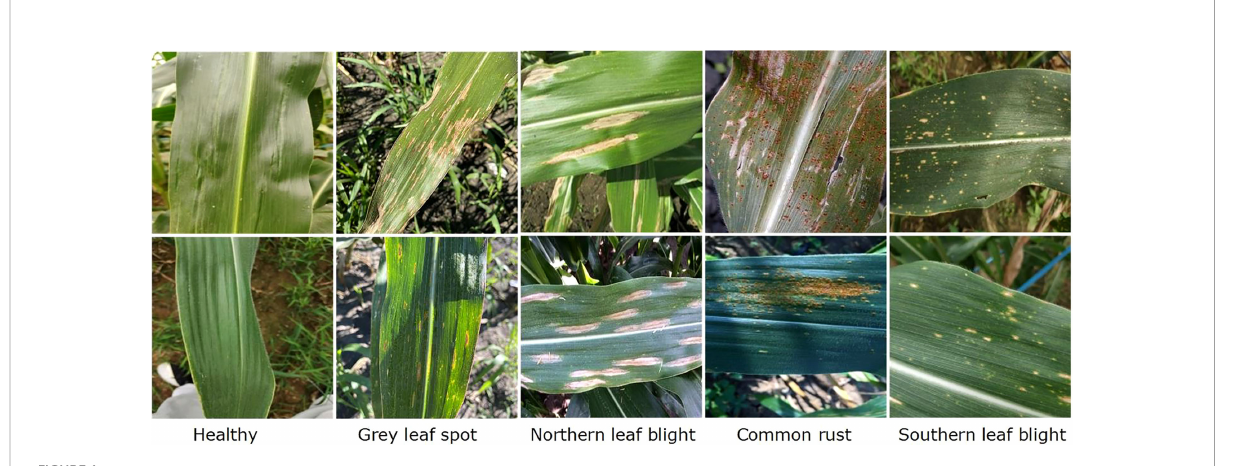
FIGURE 1 Sample images showing different types of maize leaf